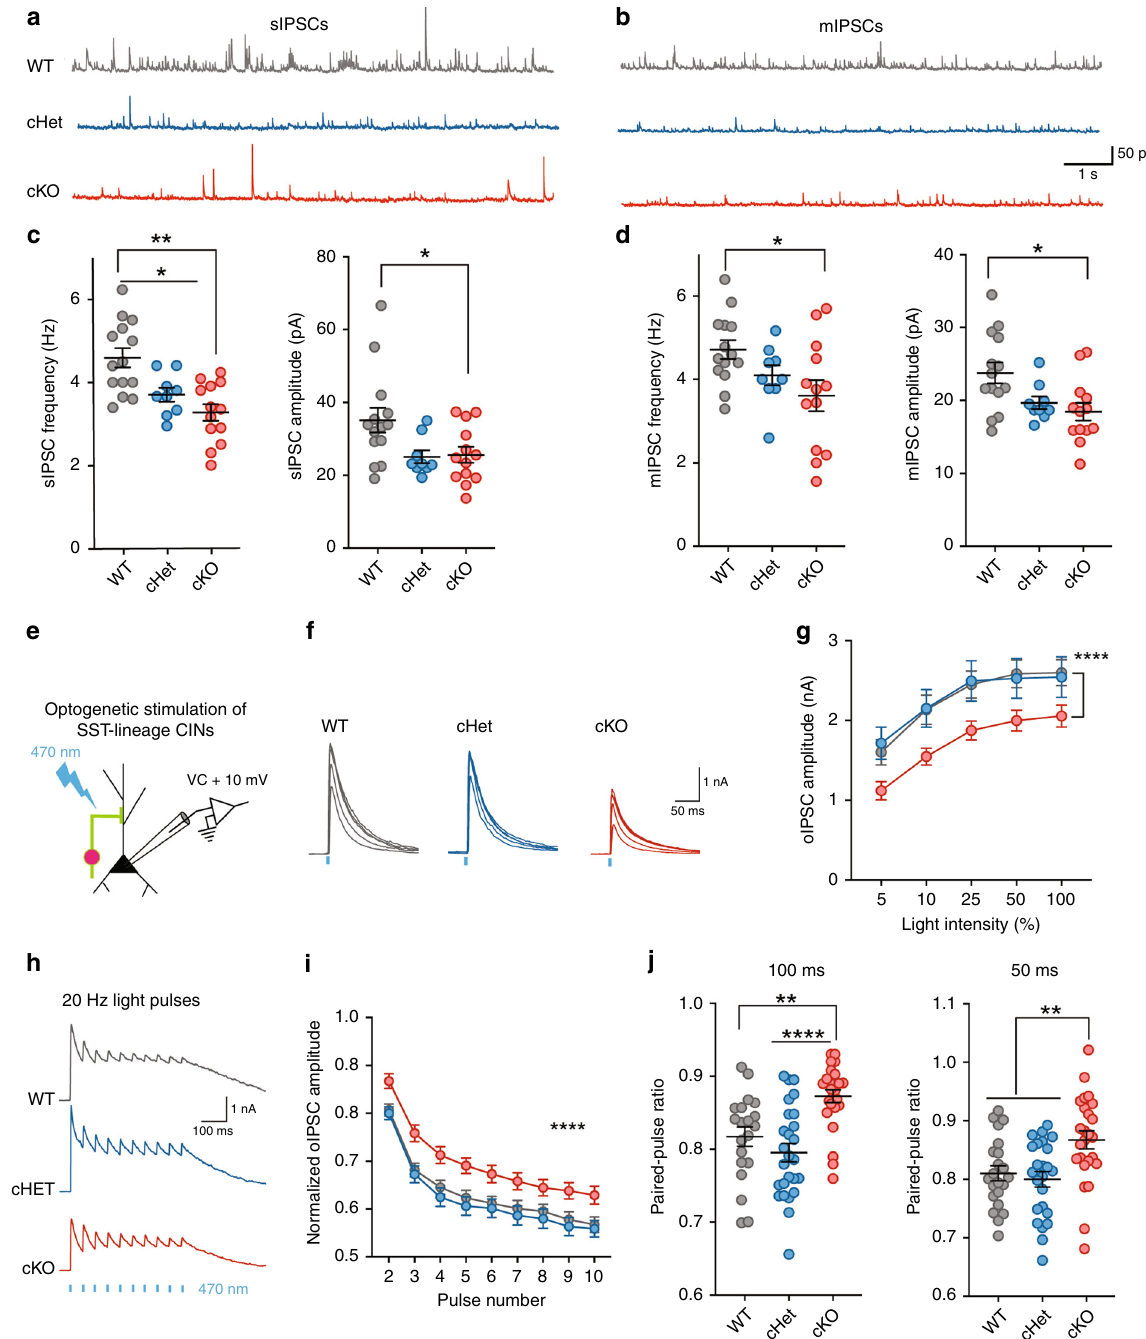
Fig. 5 Reduced inhibitory output of SST + CINs in Tsc1 cKOs. Example traces showing sIPSCs ( a ) and mIPSCs ( b) recorded from pyramidal neurons in WTs (grey), cHets (blue) and cKOs (red). Comparison of the frequency and amplitude of sIPSCs ( c ) and mIPSCs ( d ) (WT, n = 14 cells, 3 mice; cHet, n = 9 cells, 2 mice; cKO, n = 13 cells, 3 mice). One-way ANOVA with Tukey ’ s test, sIPSC Frequency: (F 2, 33 = 11.16, P = 0.0002; WT vs. cHet p = 0.02; WT vs. cKO p = 0.0002); sIPSC Amplitude: (F = 4.3, P = 0.02; WT vs. cKO p = 0.03). mIPSC Frequency: (F = 3.2, P = 0.04; WT vs. cKO p = 0.04); mIPSC 2, 33 2, 33 Amplitude: (F 2, 33 = 5.1, P = 0.01; WT vs. cKO p = 0.01). e Voltage clamp recordings were obtained from pyramidal neurons while activating